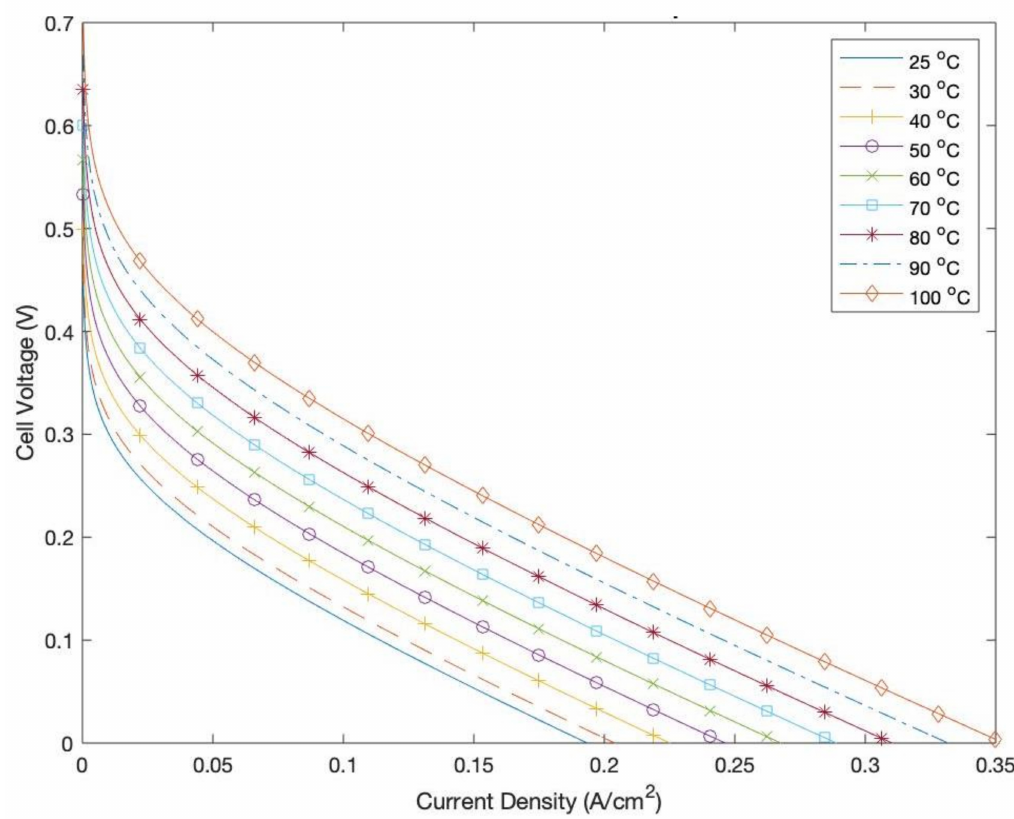
Figure 15. Polarization curve at various